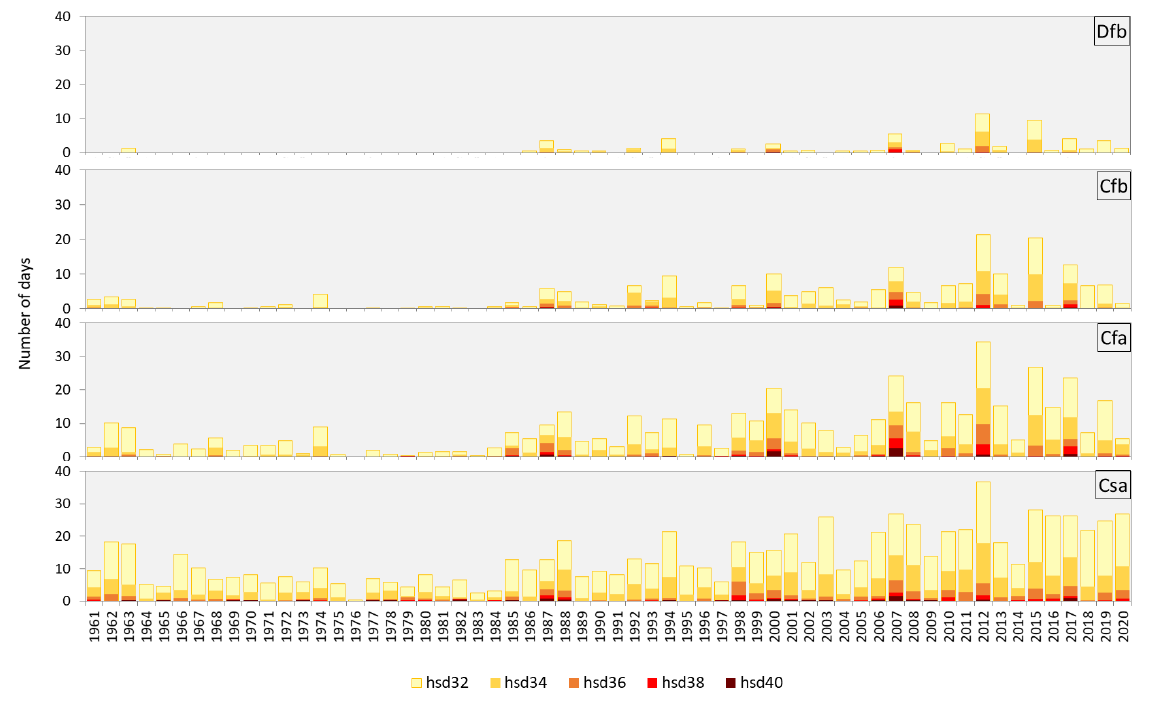
Figure 5. Long-term variations of hsd32/34/36/38/40 (unit: days) averaged by Köppen–Geiger climate zones. In the upper right corner of each panel is shown the 3-letter code of the respective climate zone.